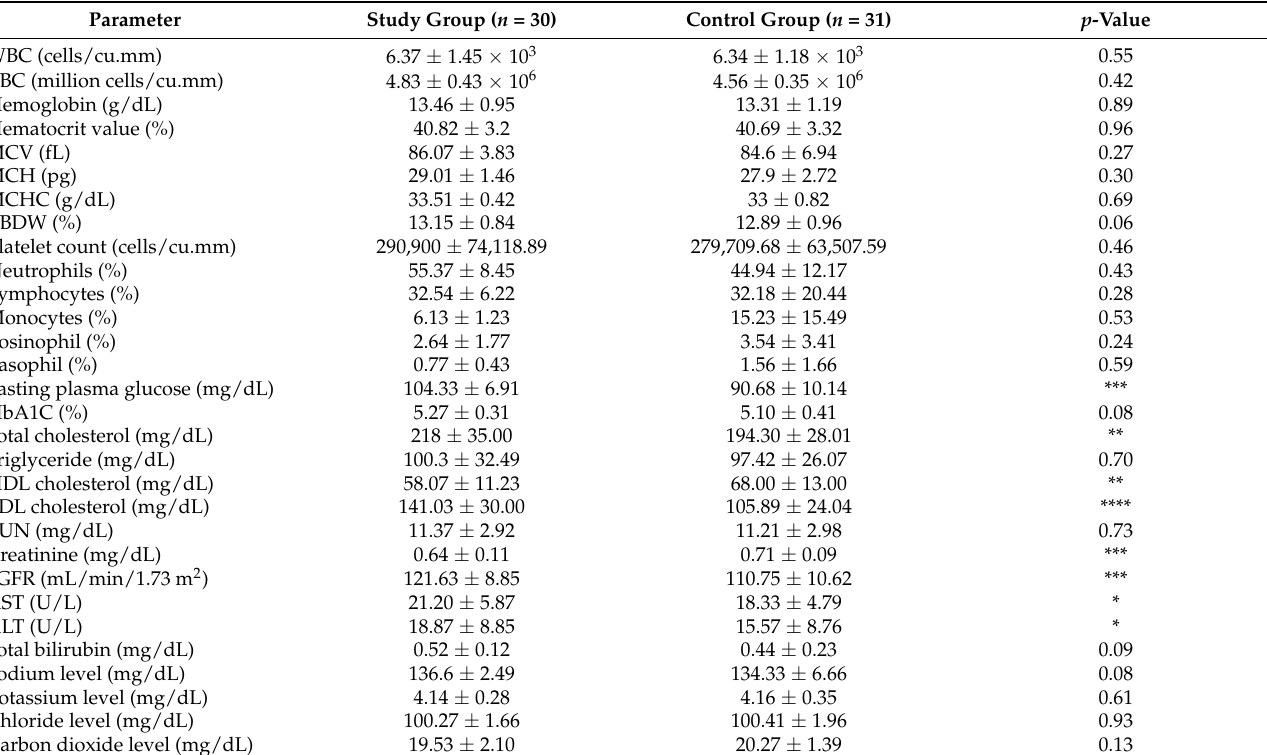
Table 2. Clinical hematological and blood chemistry values of the participants at baseline.